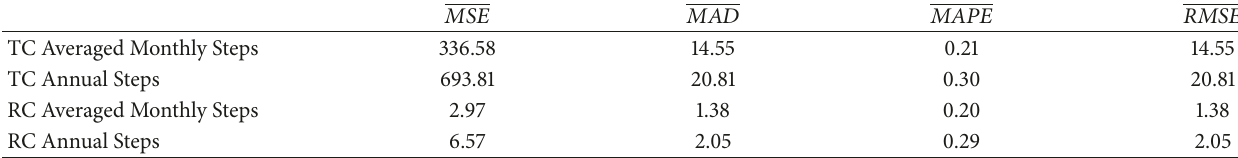
Table 5: Average for main measures of error for GBM after 1000 MC simulations for 2013.